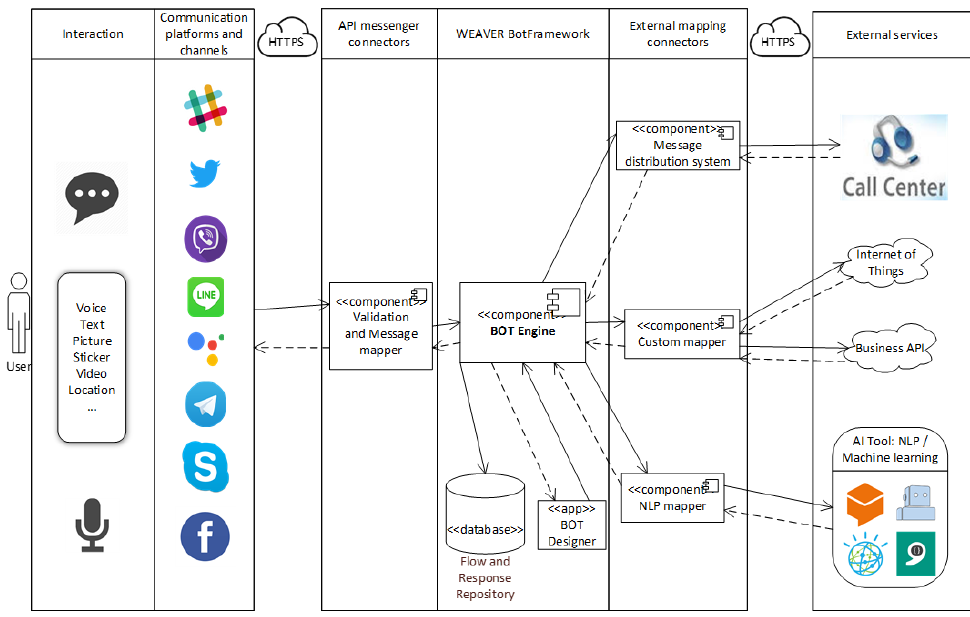
Figure 1. The logical architecture of the proposed